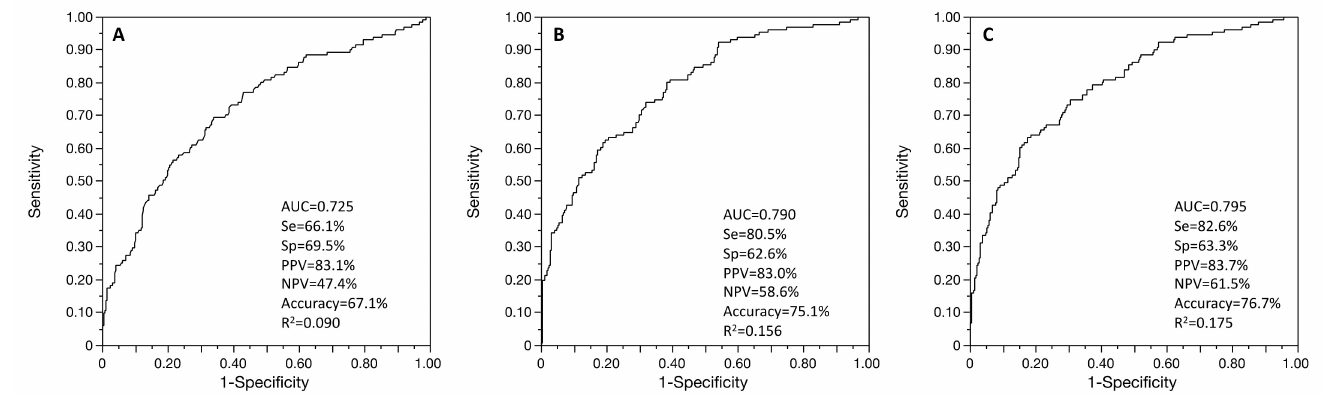
Figure 1. ROC curves of the age-adjusted associations between successful embryo culture and FOI ( A ), OSI ( B ), and multivariable regression with both FOI and OSI ( C ). Se: sensitivity; Sp: specificity;